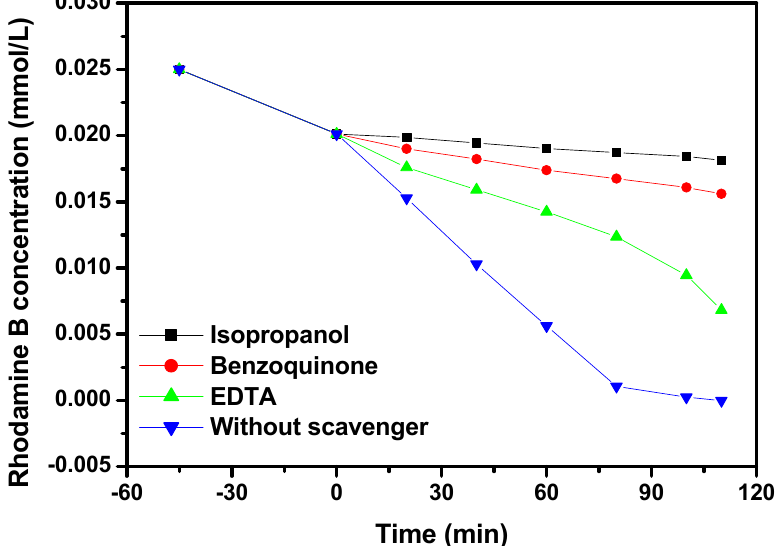
Figure 17. E ff ect of di ff erent radical scavengers such as benzoquinone (BQ), isopropanol (IPA), or Figure 17. Effect of different radical scavengers such as benzoquinone (BQ), isopropanol ethylenediamine tetraacetic acid (EDTA) on removal e ffi ciency of rhodamine B with (IPA), or ethylenediamine tetraacetic acid (EDTA) on removal efficiency of rhodamine B with In 2 CdO 4 /Y 2 SmSbO 7 nanocomposite as photocatalyzer. In 2 CdO 4 /Y 2 SmSbO 7 nanocomposite as